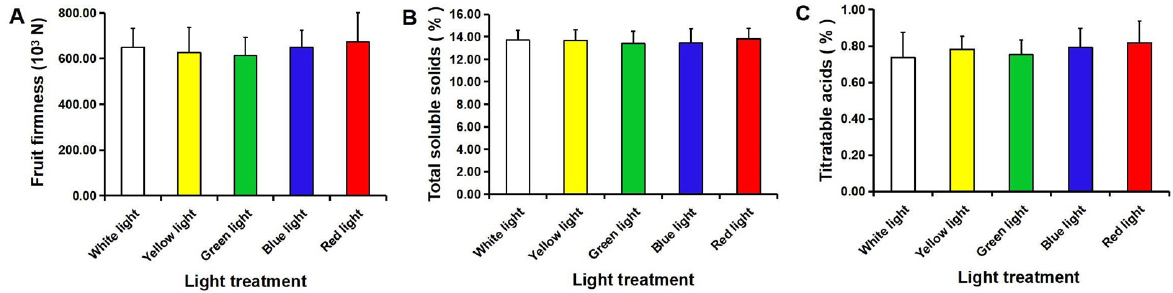
Figure 12. The fruit firmness ( A ), total soluble solids ( B ), and titratable acids ( C ) after 21 d of illumination with white, yellow, green, blue, or red LED light. The error bars represent the mean ± SD ( n = 10). Table 1. The fruit quality after low-temperature plasma treatment 1 .